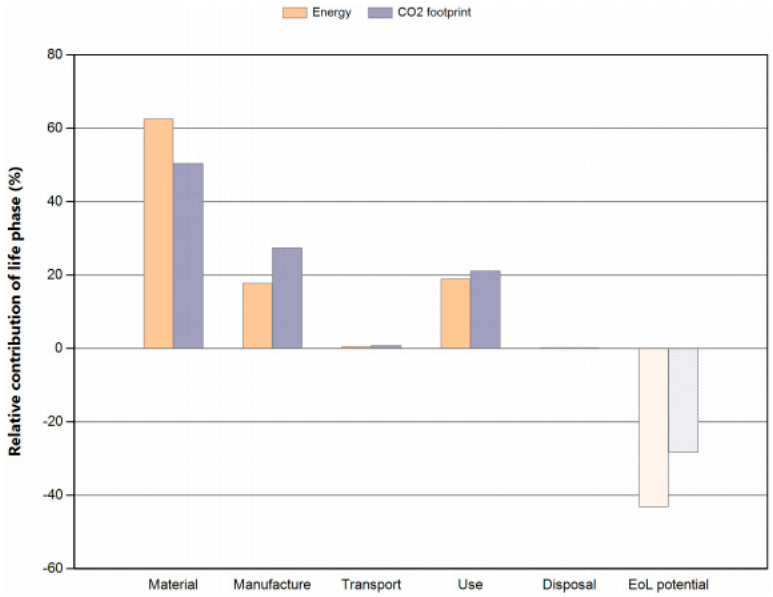
Figure 8. Eco-Audit summary chart for breakdown energy associated with each life-phase for E-glass reinforced polymer hood. Table 13. Eco-Audit report of the energy and CO 2 footprint for all hood scenarios.